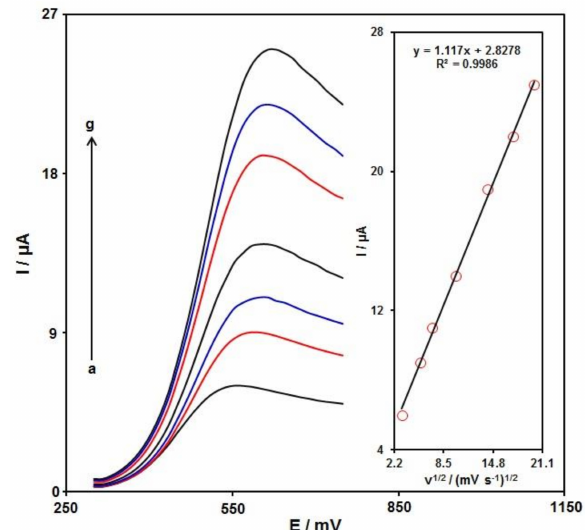
Figure 7. LSVs captured for the oxidation of sumatriptan (100.0 µ M) on the Ni-Co LDH/SPE under variable scan rates (a–g: 10, 30, 50, 100, 200, 300, and 400 mV/s). Inset: correlation of Ipa with V 1/2